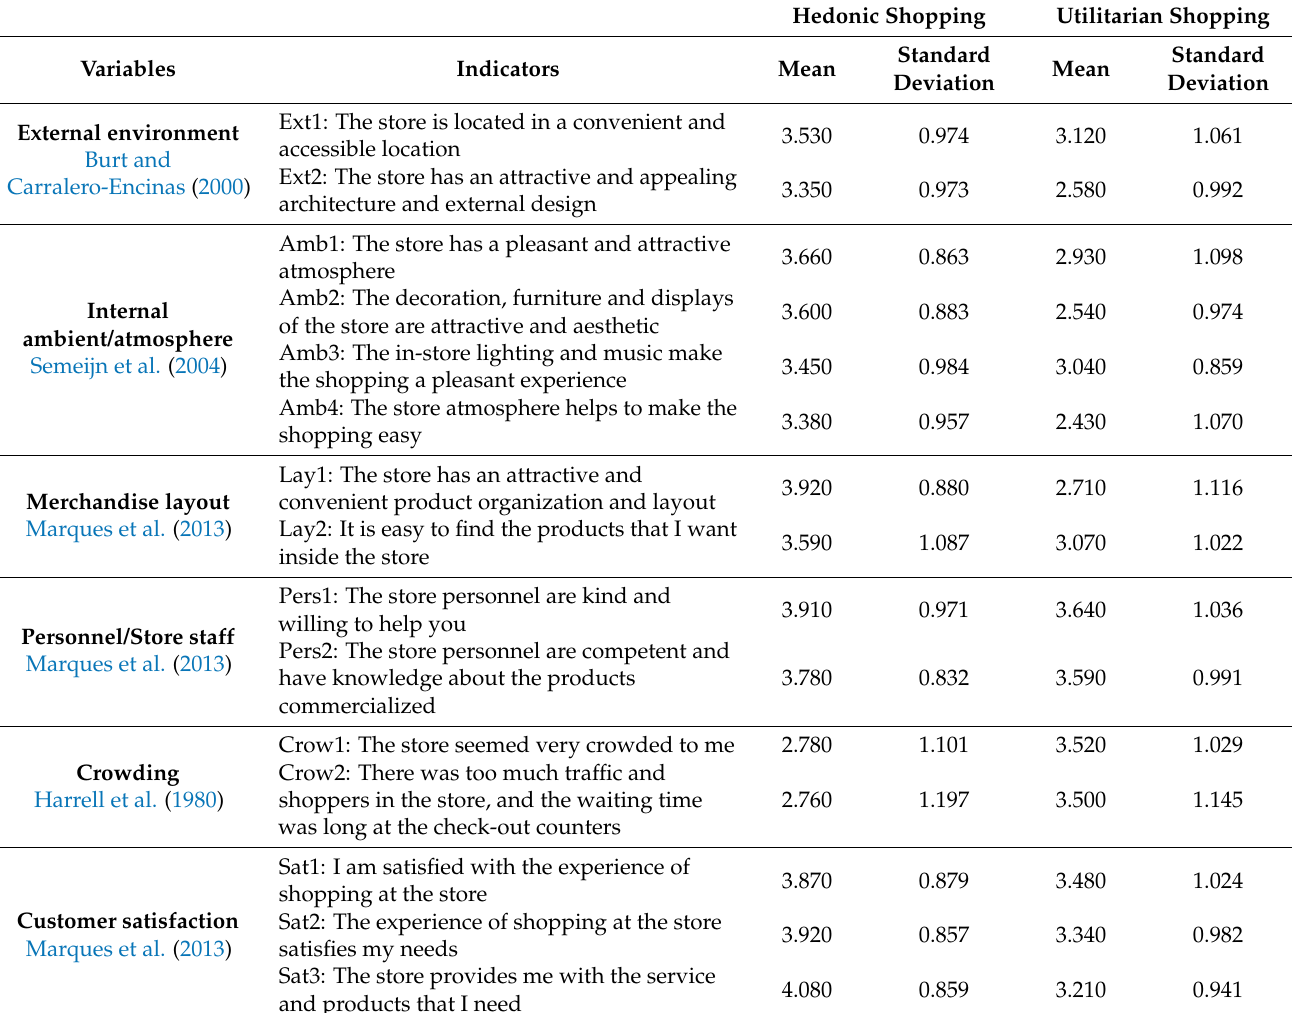
Table 1. Measurement scale, indicators, and descriptive